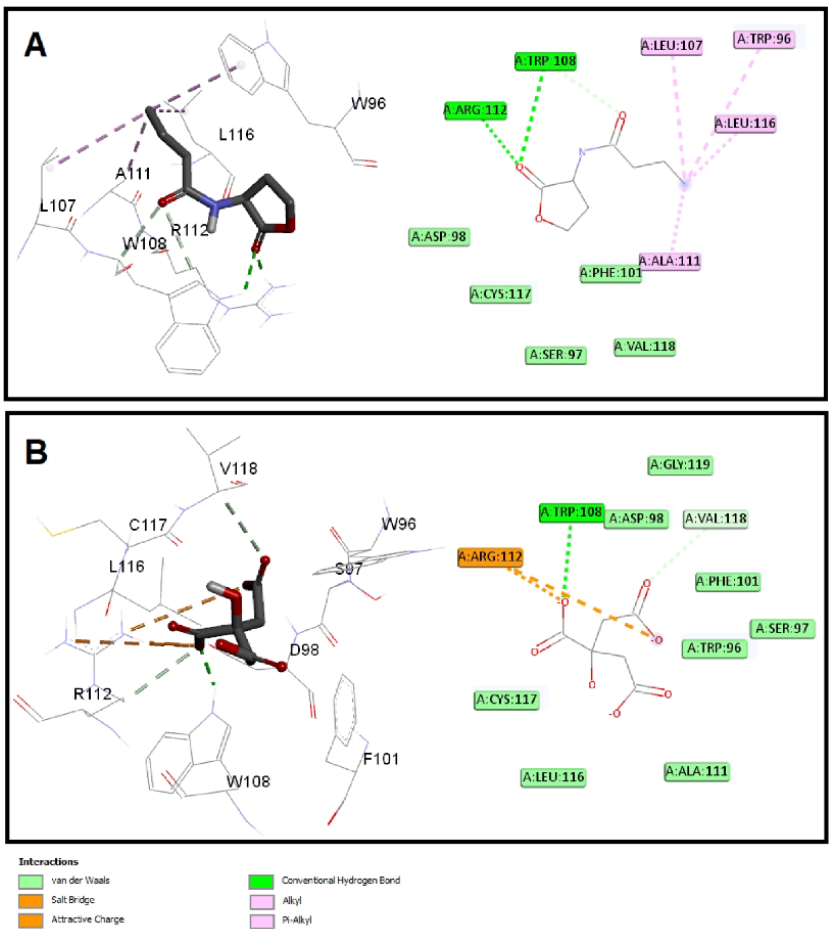
Figure 8. Molecular docking of ( A ) citrate and ( B ) C4-HSL into the active site of RhlR protein 3D representation (left) and 2D Schematic interaction (right). Citrate could bind with the RhlR receptor and interfere with the P. aeruginosa QS systems.